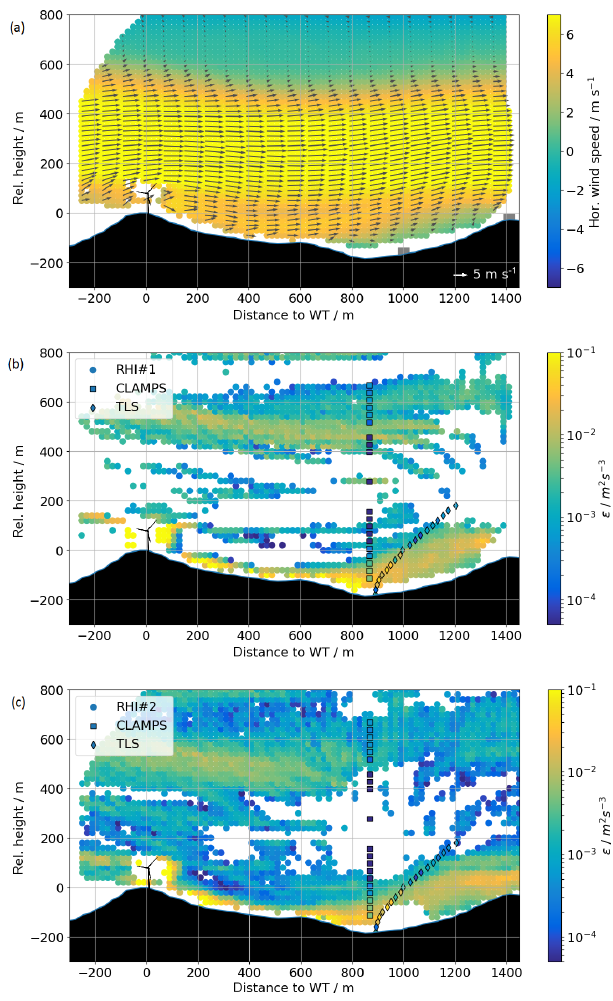
Figure 10. In panel (a) the coplanar wind field reconstruction from RHI#1 and RHI#2 from averaged RHI scans between 04:00 and 04:30UTC is shown. The arrows show the wind vectors projected onto the RHI plane as retrieved with the coplanar method (Wild- mann et al., 2018a). The color map is scaled with the horizontal wind component of the projected wind vector. Panels (b, c) show dissipation rates as estimated from vertical stare and TLS on RHI scans by RHI#1 (b) and RHI#2 (c) for the same time period. The origin of the local coordinate system in this and all the following plots is at the wind turbine base location on the SW